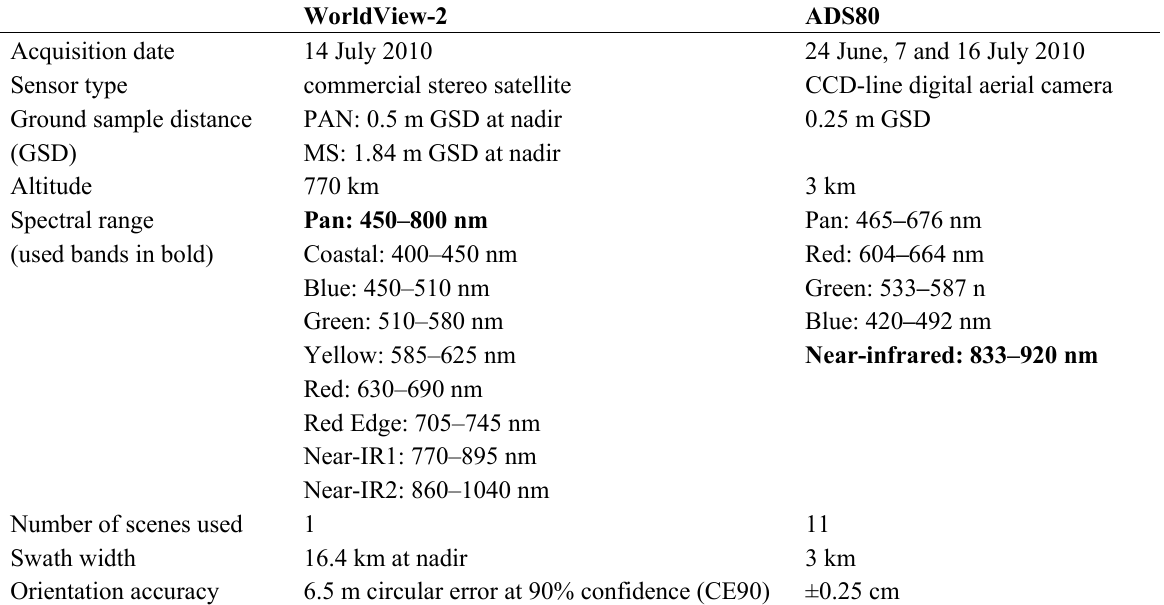
Table 1. Characteristics of the sensors used (WorldView-2 and